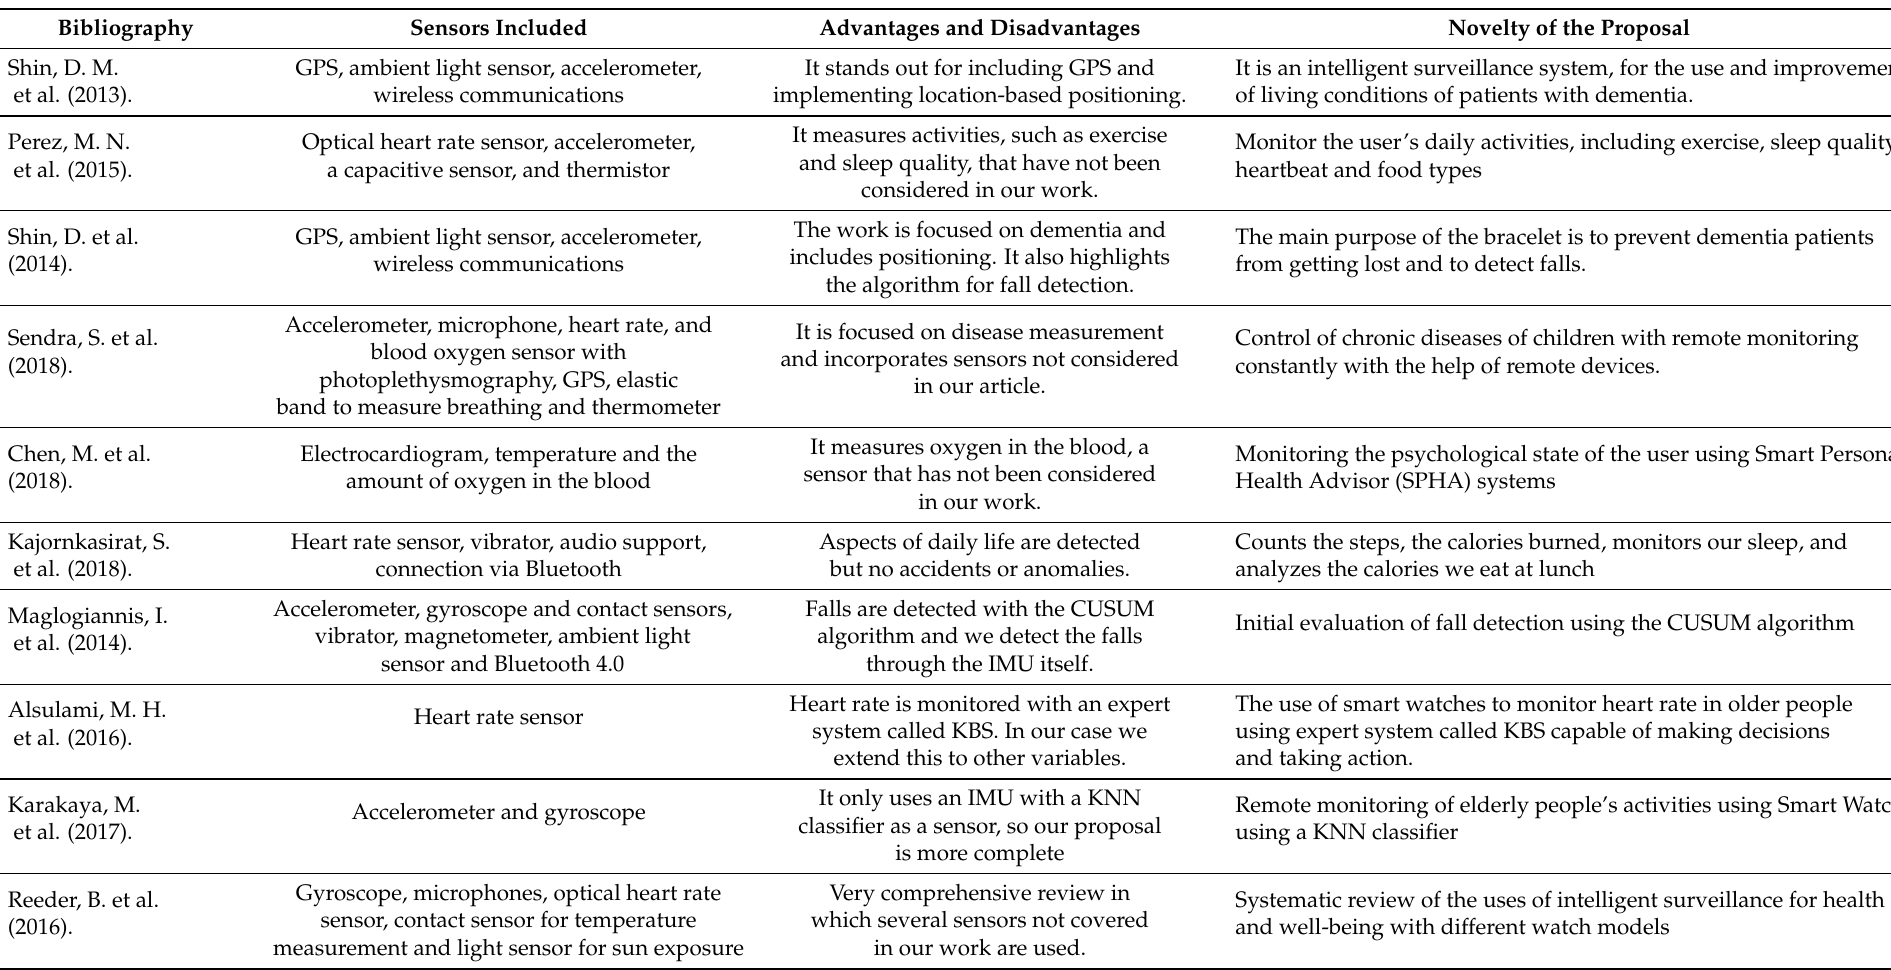
Table 1. Proposals related to wearable monitoring and sensor networks in a wrist